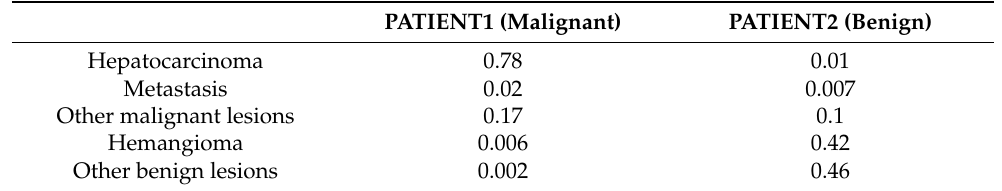
Table 7. Results for two samples selected from the